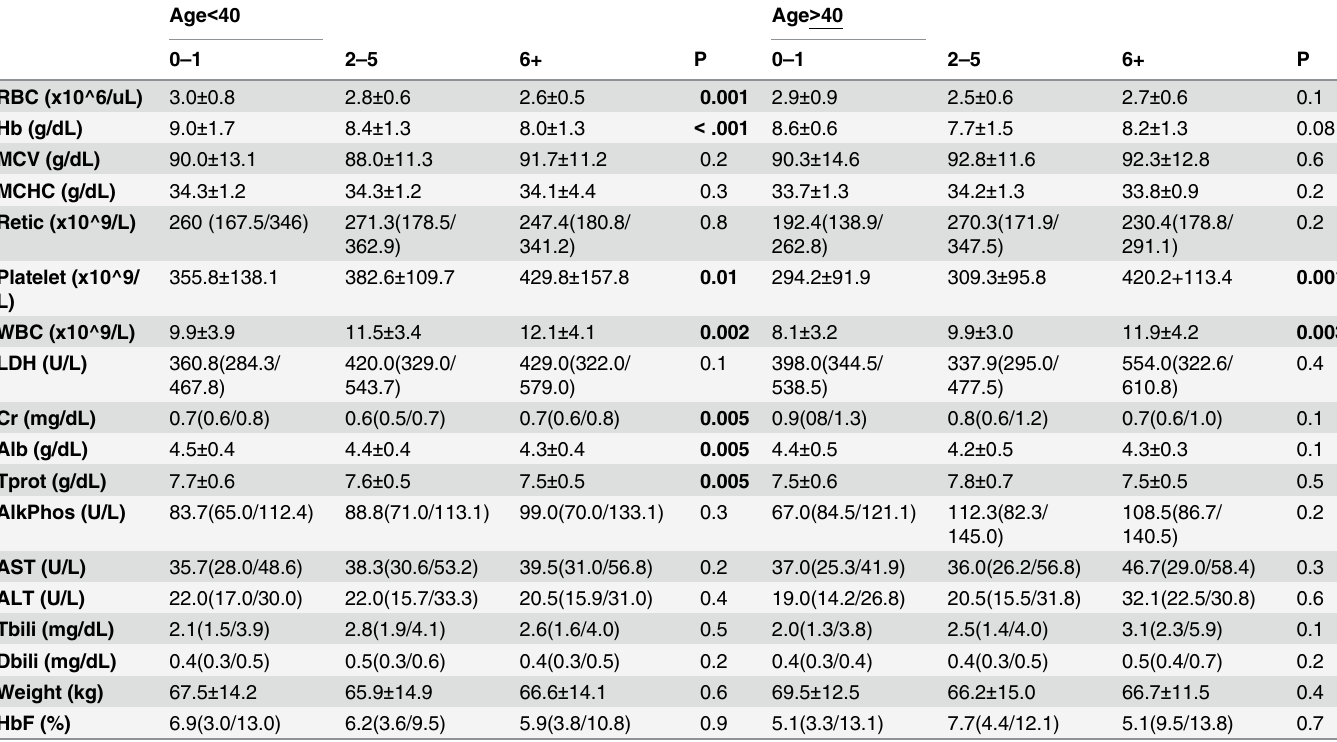
Table 5. Steady state laboratory determinants for each ED utilization for younger ( < 40yrs) and older ( (cid:1) 40yrs) cohorts. Normalized data reported as means with SDs, non-normalized data reported as medians with 25% and 75% P values are for ANOVAs done over all 3 categories. Age < 40 Age >